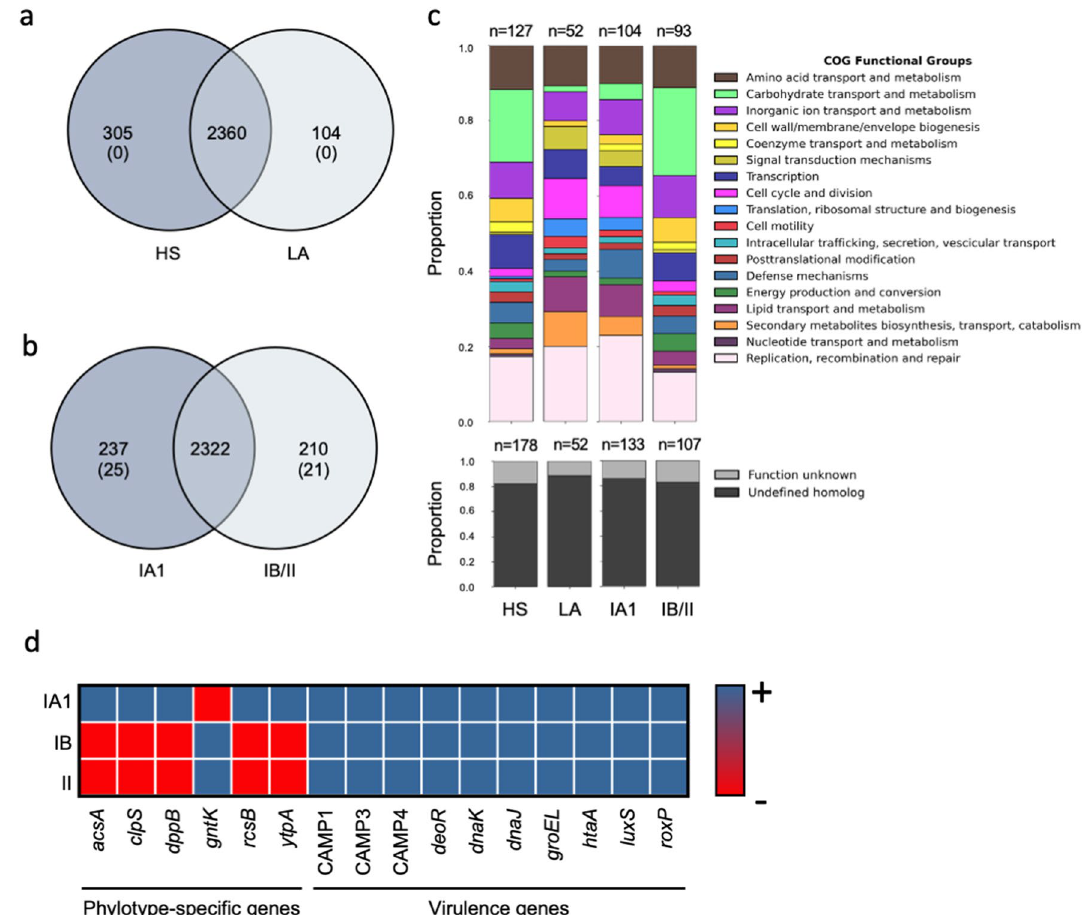
Figure 3. Shared and unique genes in 20 C. acnes strains. Venn diagrams display the distribution of shared and unique genes between ( a ) C. acnes strains from healthy subjects (HS) and the lesional area of acne patients (LA) and ( b ) phylotypes IA1 and IB/II. Overlapping regions show the genes conserved within strains. The number between brackets represents the unique genes present in all the strains of a particular group. ( c ) The stacked bar chart of Cluster of Orthologous Genes (COGs) functional category proportions is based on the unique genes in all groups. The n above each group indicates the absolute count of COGs identified in each group. ( d ) Similarity matrix categories represent the presence (blue; +) or the absence (red, -) of C. acnes virulence genes and phylotype-specific